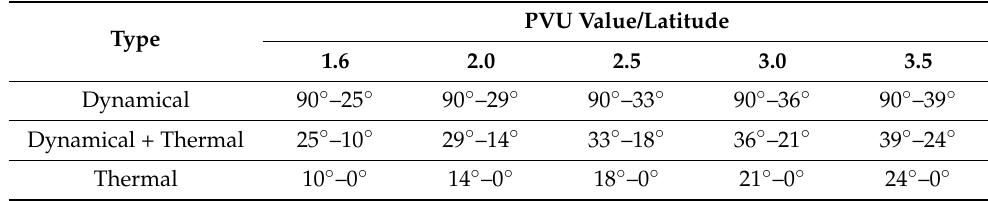
Figure 1. An example of combining the thermal and dynamical (3.0 PVU surface) tropopauses to overcome the limitation of the dynamical tropopause over the tropics. The brown and black lines represent the thermal and dynamical tropopause mean zonal profiles. The light brown line is a weighted average of both, for a zonal band of 15 ◦ , indicated by the horizontal lines. Table 1. Latitude bands (in absolute values) to combine thermal and dynamical tropopauses. The middle band (Dynamical + Thermal) is used to ensure continuity and